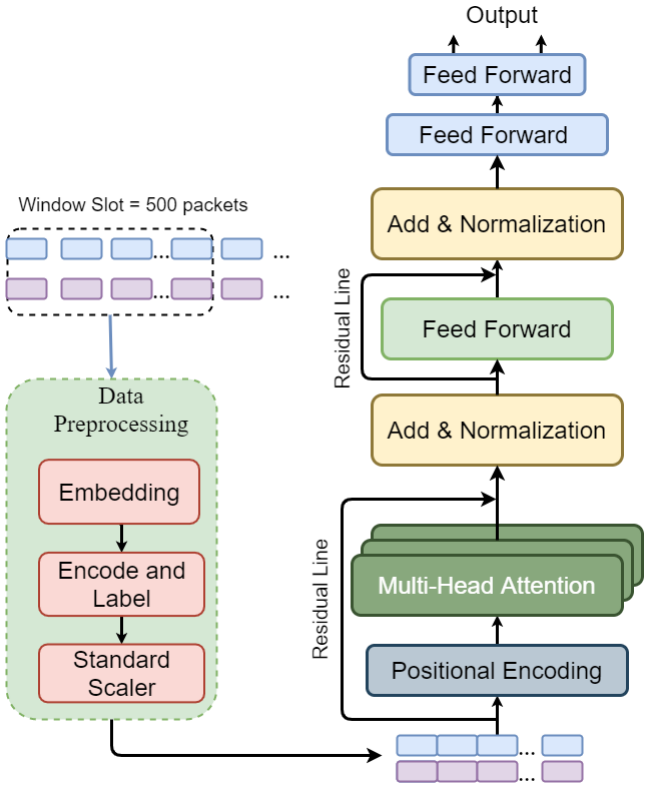
Figure 6. Model flow